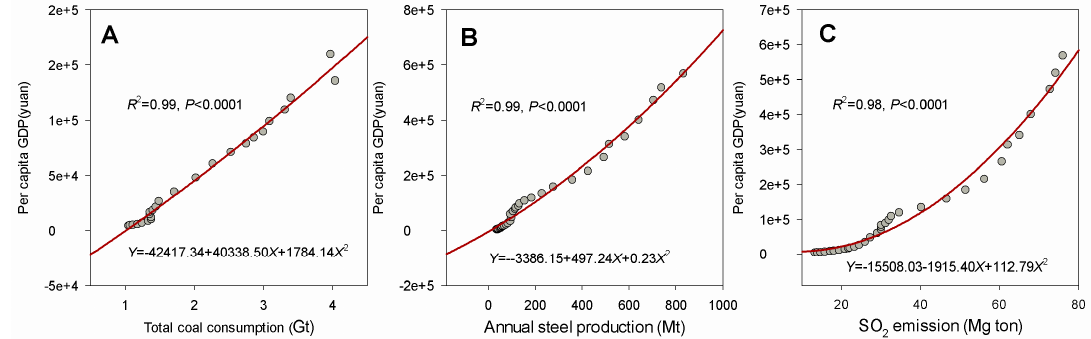
Figure 2. The quadratic regression analysis of the total coal consumption ( A ); the annual steel production ( B ); the SO 2 emission ( C ) with the per capita GDP. All documents are extracted from the